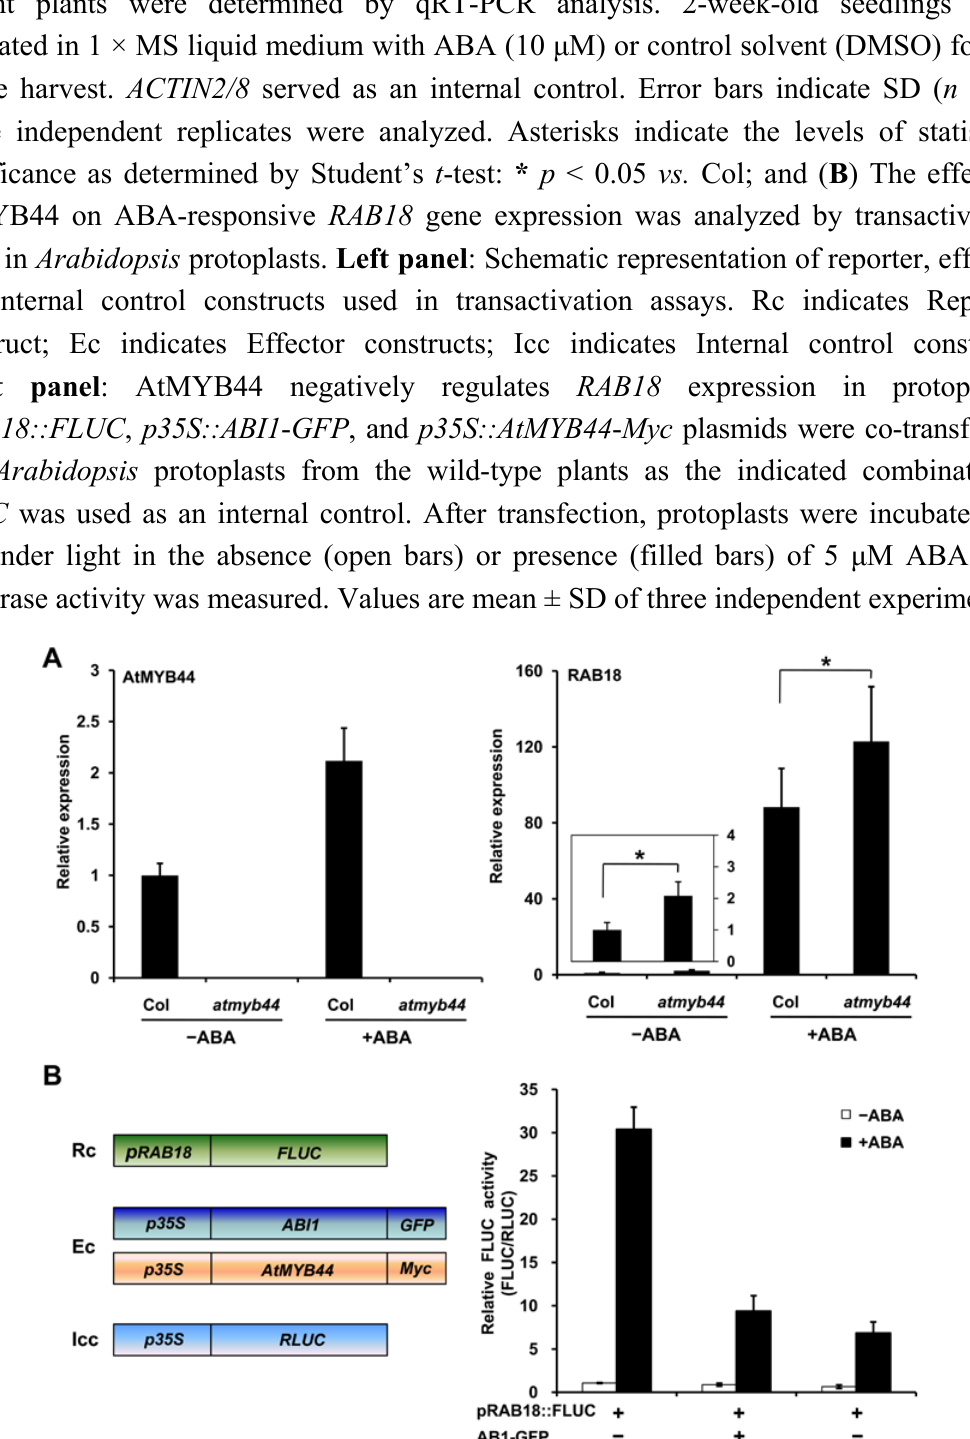
Figure 3. AtMYB44 negatively regulates the expression of ABA-responsive gene RAB18 . ( A ) Relative expression levels of AtMYB44 and RAB18 in wild-type (Col) and atmyb44 mutant plants were determined by qRT-PCR analysis. 2-week-old seedlings were incubated in 1 × MS liquid medium with ABA (10 μM) or control solvent (DMSO) for 2 h before harvest. ACTIN2/8 served as an internal control. Error bars indicate SD ( n =